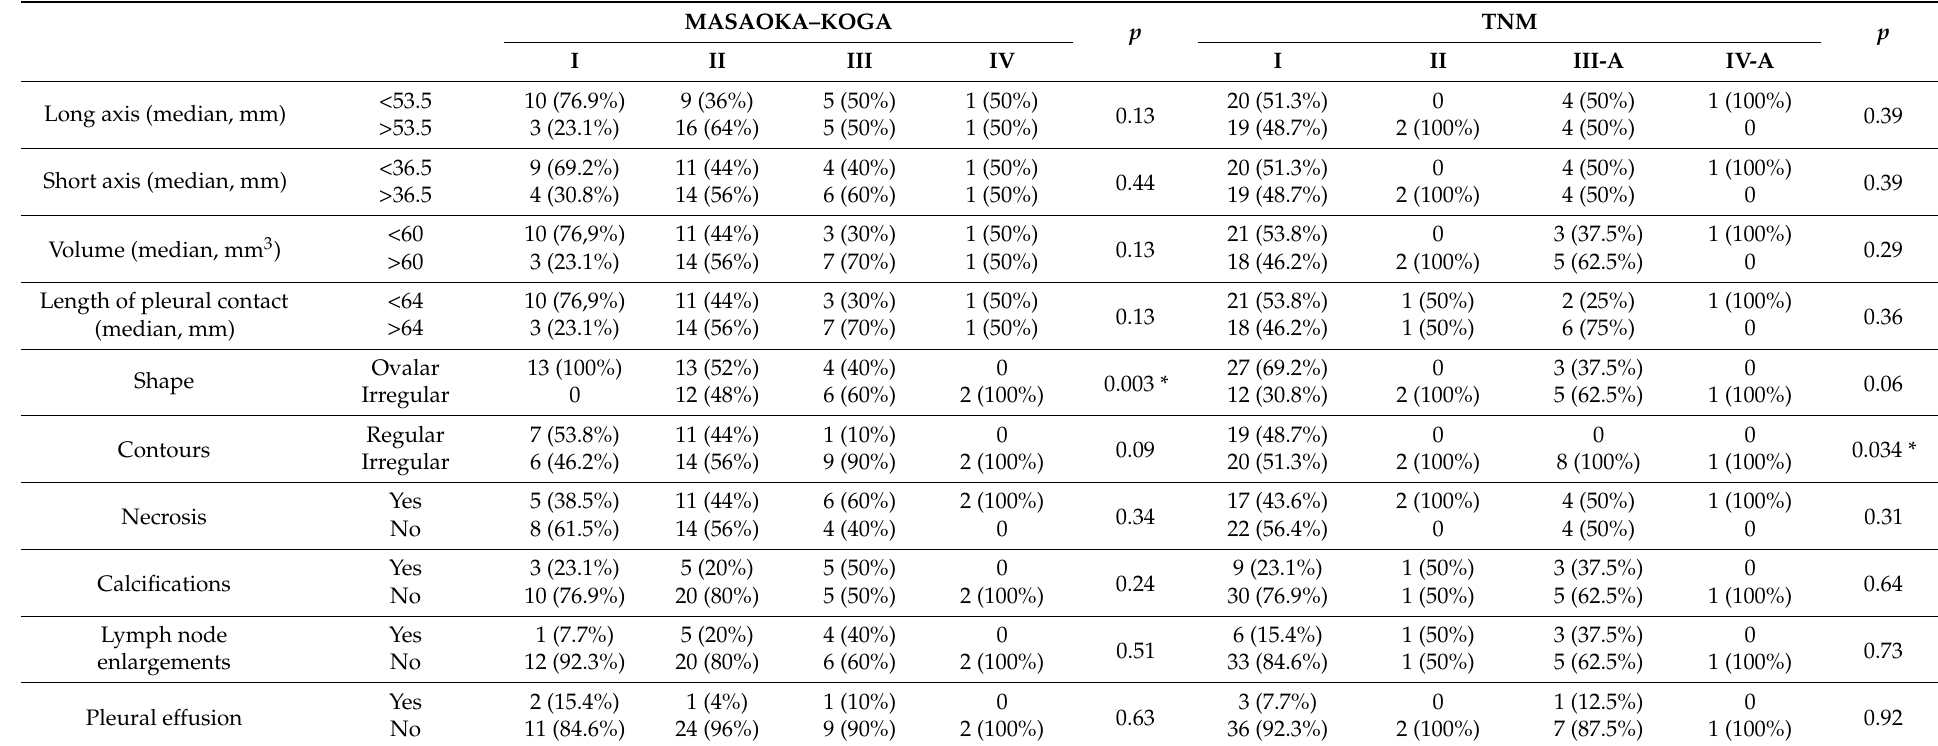
Table 4. Correlation between computed tomography (CT) parameters and